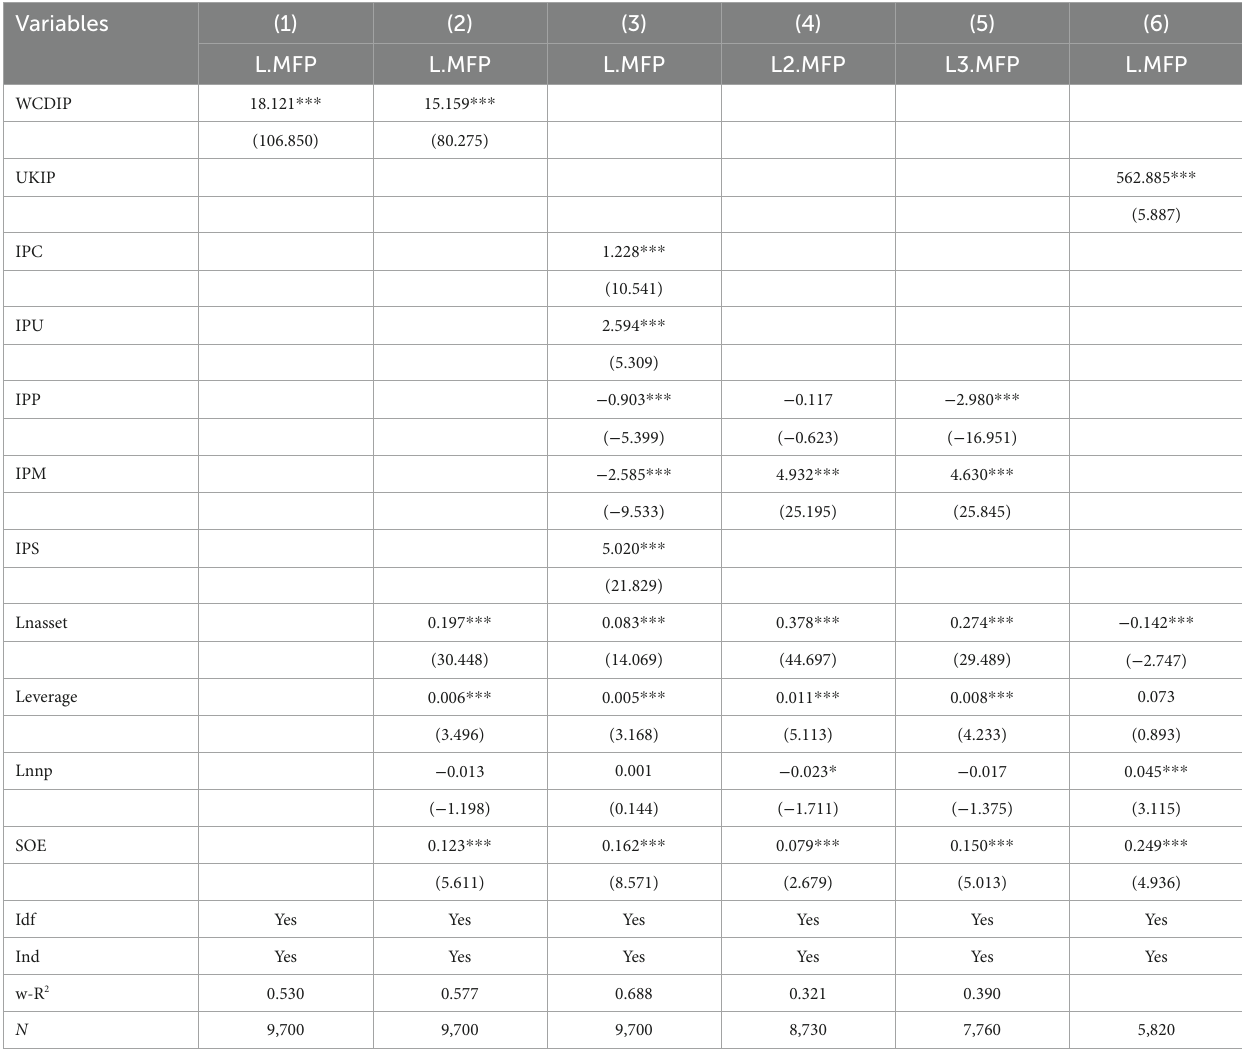
TABLE 3 The impact of WCDIP on MFP and endogeneity test.